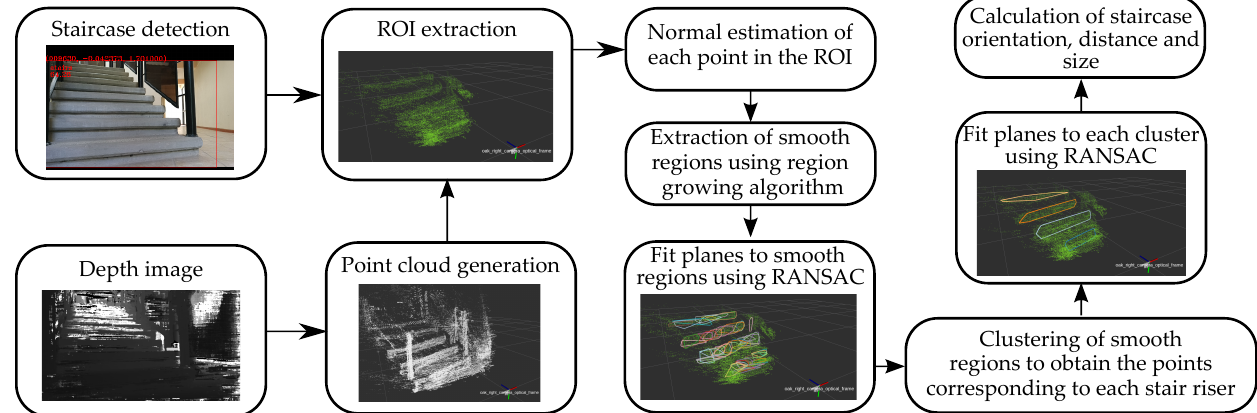
Figure 1. Staircase detection and characterization pipeline used for the OAK-D